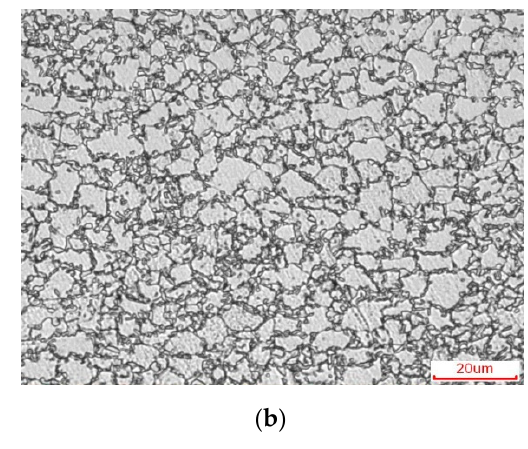
Figure 2. Quasi-static tensile specimens with thickness 1.5mm (unit=mm).